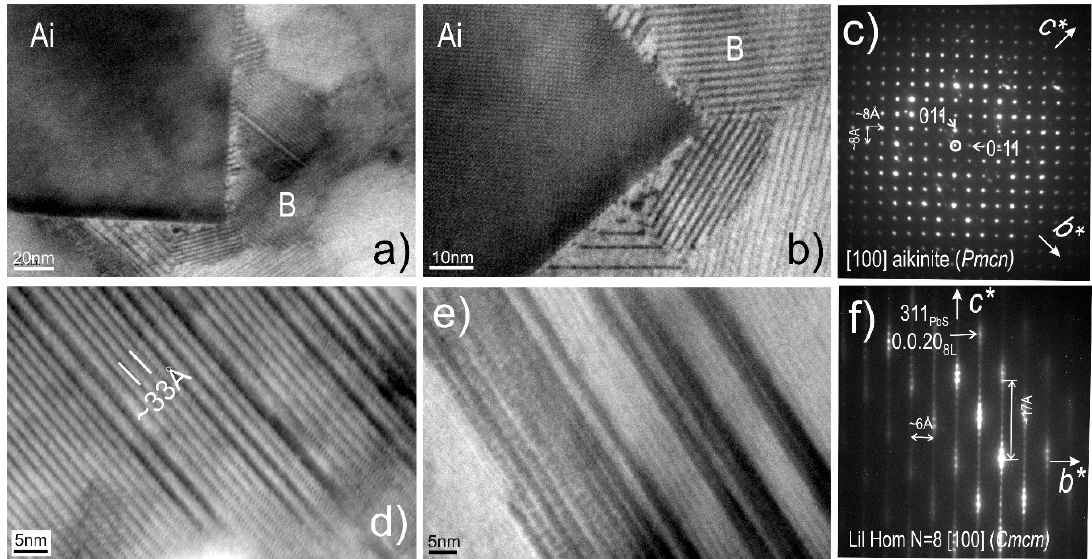
Figure 7. Bright Field (BF) HR-TEM images and SAEDs (on zone axes as marked) showing associations between aikinite (Ai; a – c ) and the bright Pb-Bi-sulphosalt (phase B) identified as N = 8 lillianite homologue ( 8 L; d – f ). Note the fine-grained aggregate of B at the boundary to aikinite ( a , b ), and the high contrast between different slabs typical of twinning in lillianite homologues. Note the presence of streaks along c* and equivalent directions indicating disorder in 8 L. See text for additional explanation.